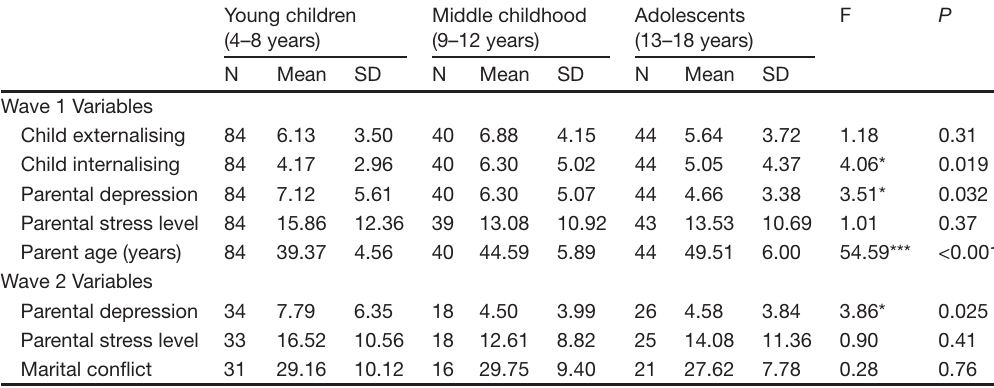
Table 2. Descriptive statistics by child age group